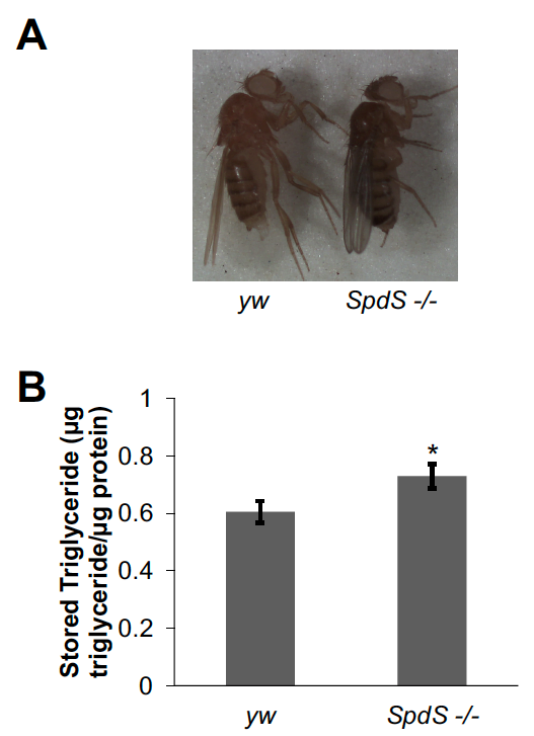
Figure 1. Spermidine synthase ( SpdS ) mutant flies have augmented triglyceride storage. ( A ) One-week-old female SpdS -/- flies had a larger abdomen compared to yw controls. A representative image is shown. ( B ) Triglycerides were measured in SpdS -/- mutants by homogenizing pairs of one-week-old adult female flies and yw controls. Triglyceride measurements were normalized by dividing by total protein content. Bars represent means ± S.E. ( n = 23–25). * p < 0.05 using Student’s t -test comparing SpdS -/- to yw controls.